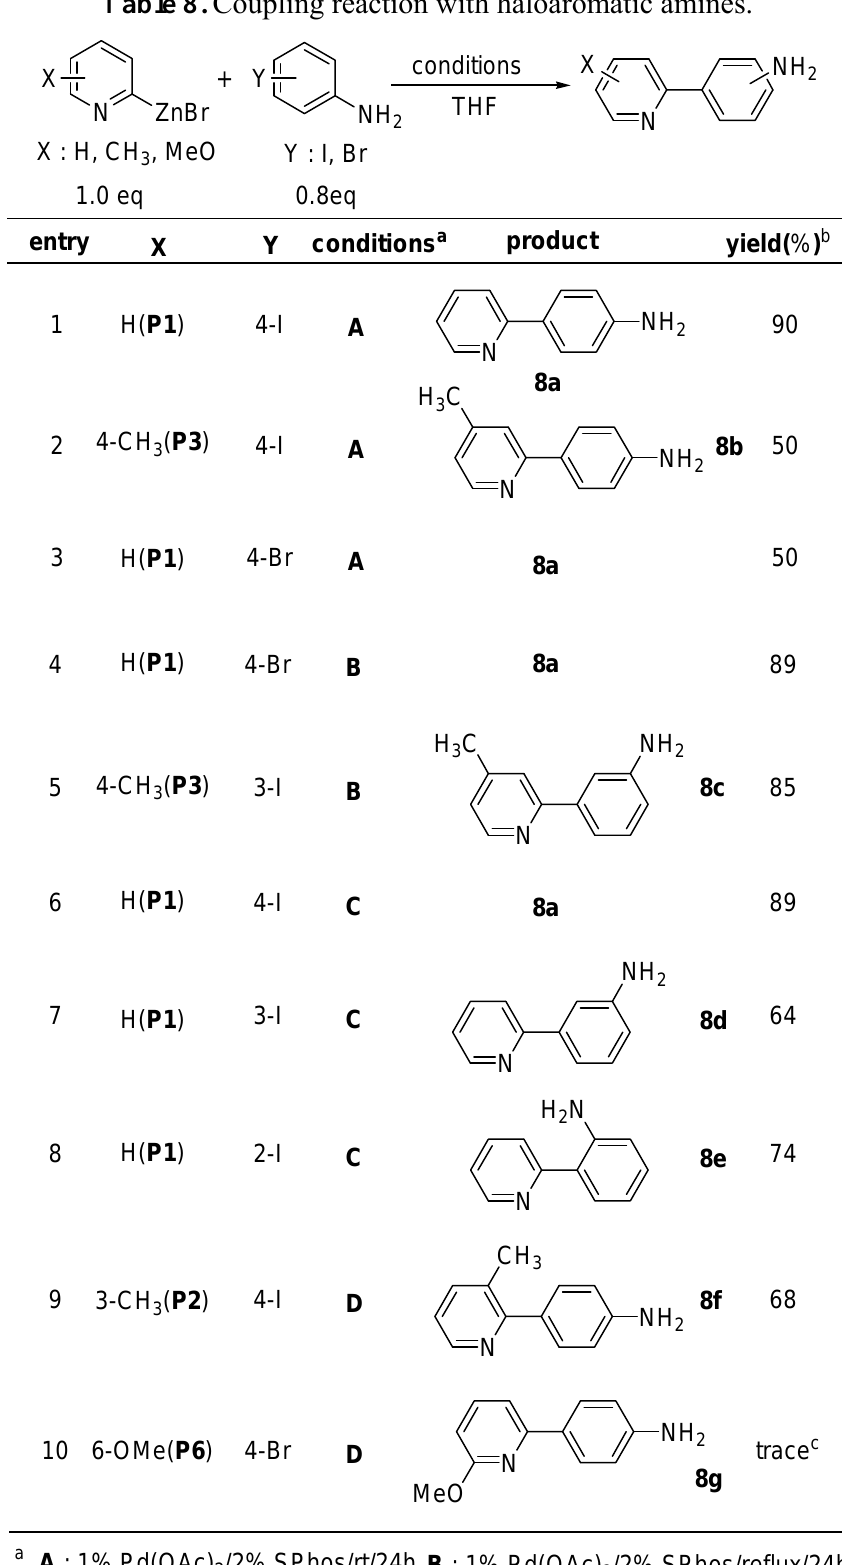
Table 8. Coupling reaction with haloaromatic